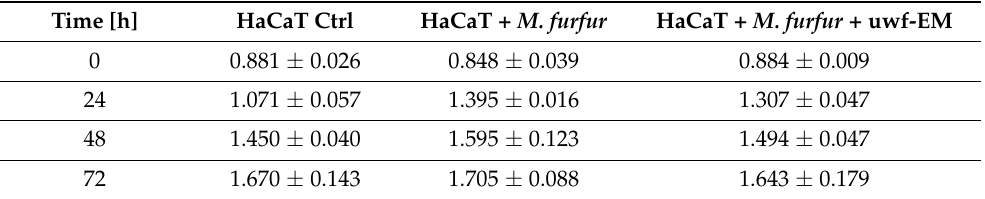
Table 2. Numeric representation of CFUs versus time as averages of three replicates along with the corresponding standard deviations. Time [h] HaCaT